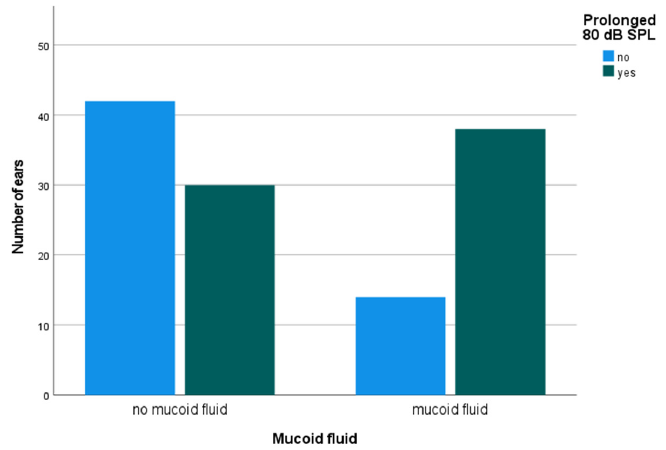
Figure 2. Prolonged latency of wave I (males > 1.95 ms, females > 1.88 ms) at 80-dB SPL during intraoperative auditory brainstem response testing comparing ears with and without mucoid fluid (n = 124 ears).